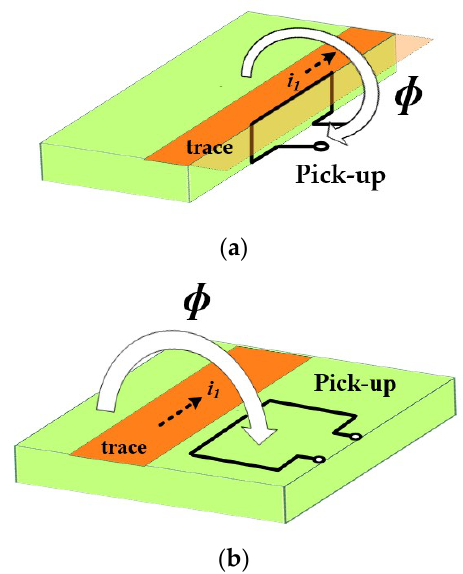
Figure 1. Schematic of the pickup coil in PCB: ( a ) vertical structure and ( b ) horizontal structure.